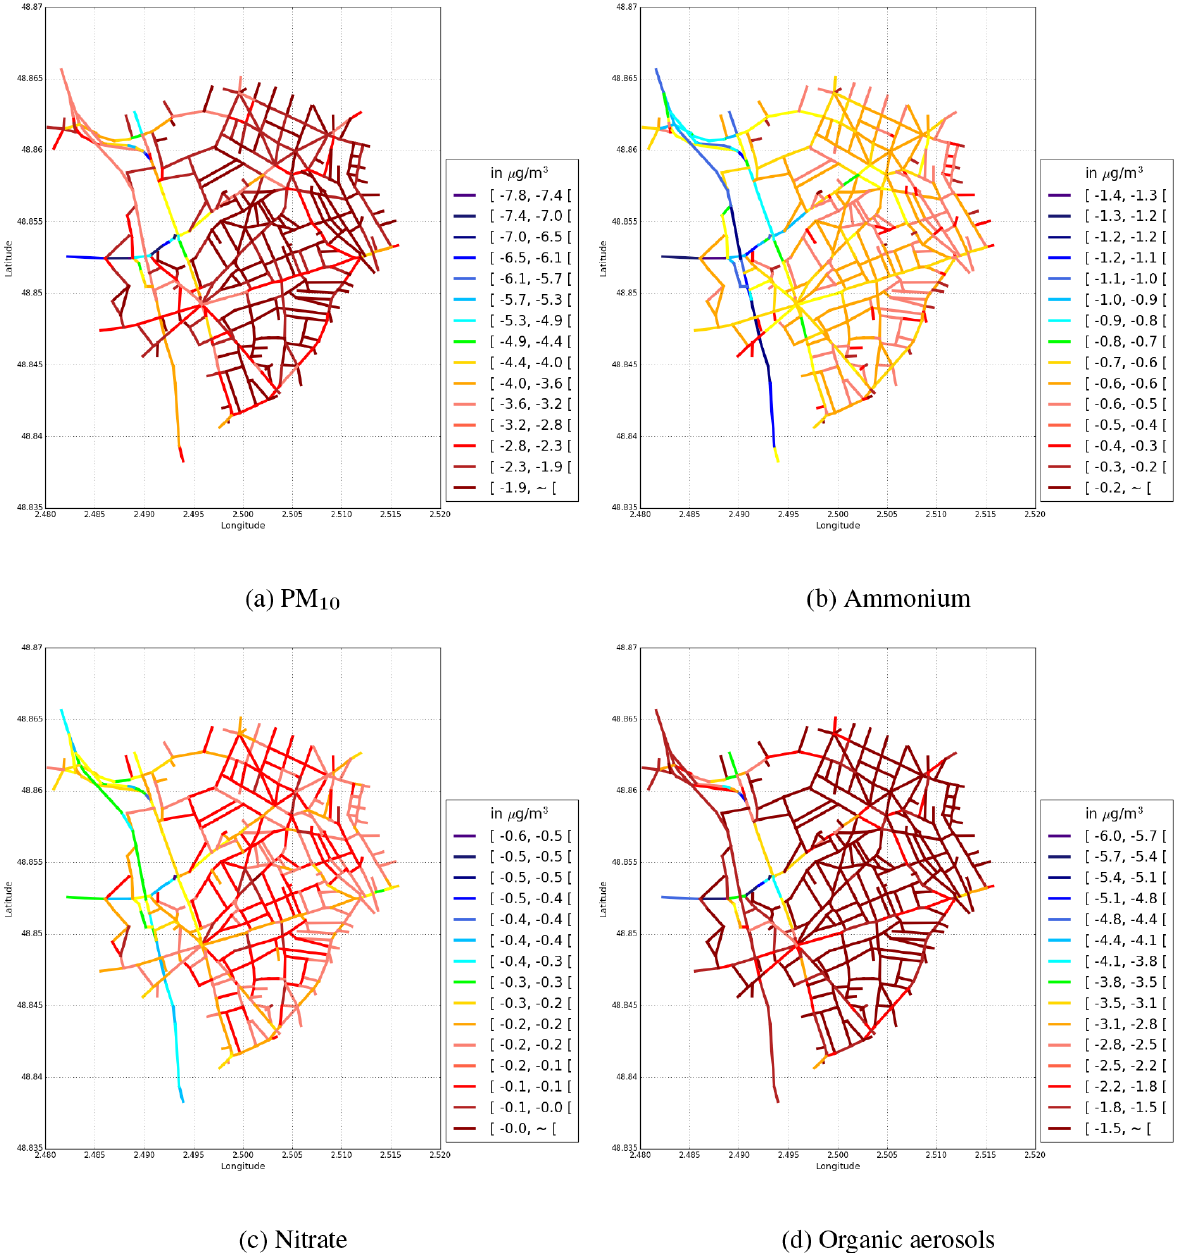
Figure C2. Differences in time-averaged concentrations (in µgm − 3 ) between Case-2 and Case-1 (Case-2 − Case-1) for (a) PM 10 , (b) am- monium, (c) nitrate, and (d) organic